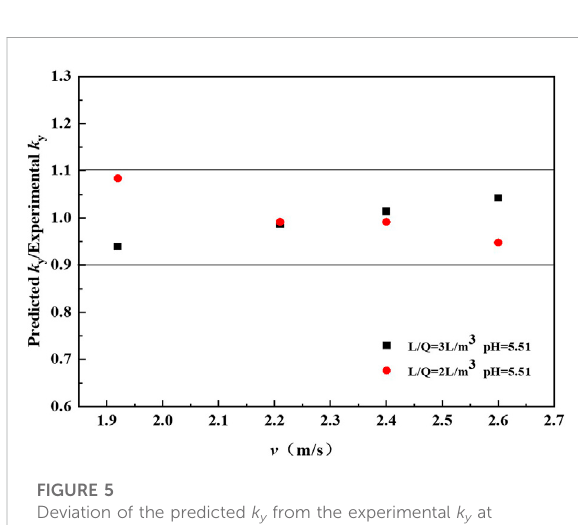
FIGURE 5 Deviation of the predicted k y from the experimental k y at different u g.